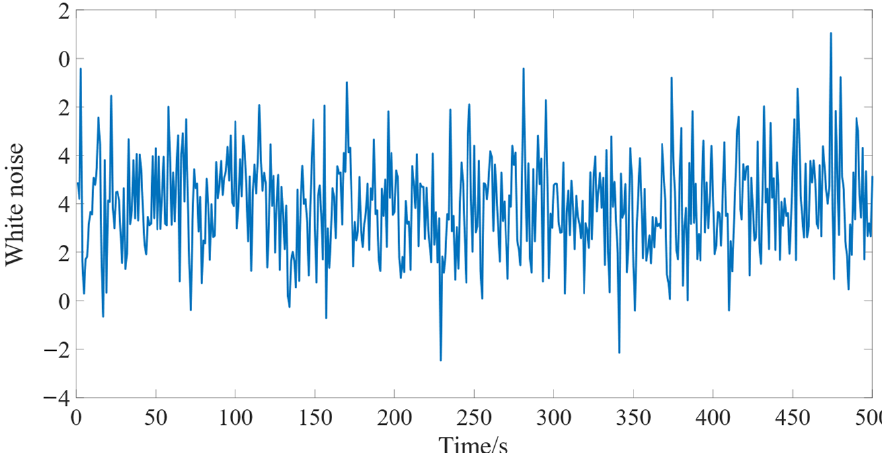
Figure 3. Sequence diagram for white noise.